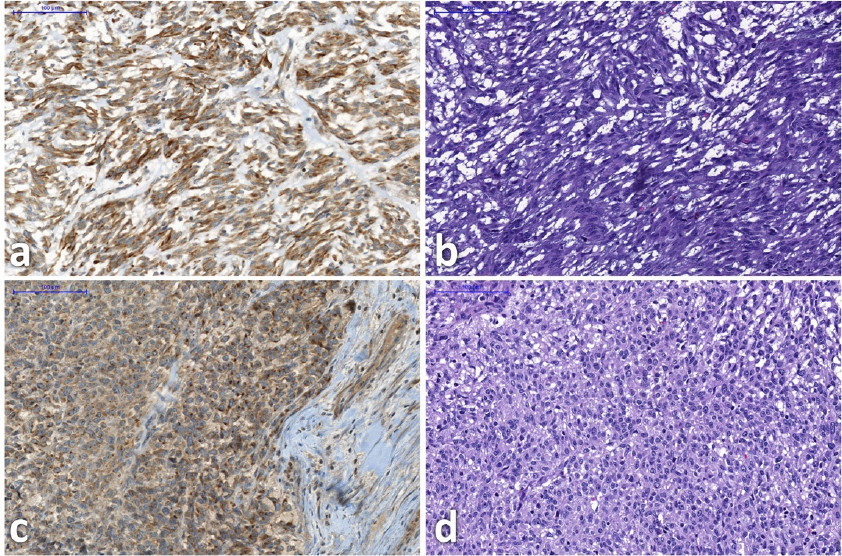
Figure 3. Gastrin-releasing-peptide-receptor immunohistochemistry staining (left side) and correlating hematoxylin-eosin staining (right side) in participants 2 ( a , b ) and 3 ( c , d ). Images show representative tumor areas. Due to the nature of slide preparation and staining, slides do not fully align. In all samples, moderate (patients 6, 7, and 9) or strong expression of GRPR (patients 2, 3, and 8) were reported. No significant difference in 68 Ga-NeoBOMB1 uptake was ob- served regardless of observed reference lesion GRPR expression (Figure 4a), yet all mes- enterial lesions were positive in PET; 40.0% of lesions in the liver; and none in the